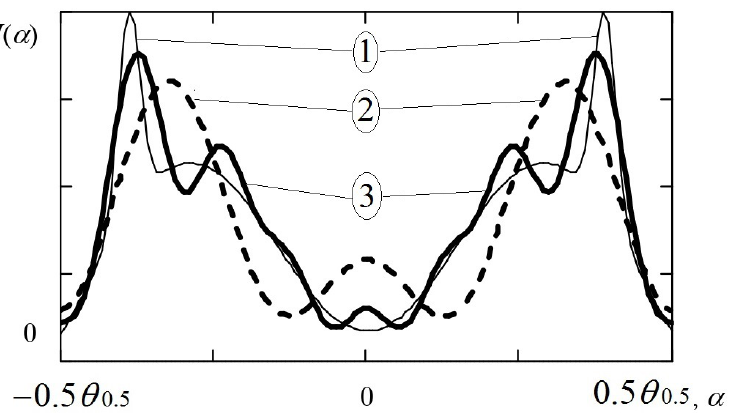
Figure 4. The original and reconstructed image of a complex object: 1-true distribution I ( α ) ; 2- solution found by the algebraic method; 3-solution for the